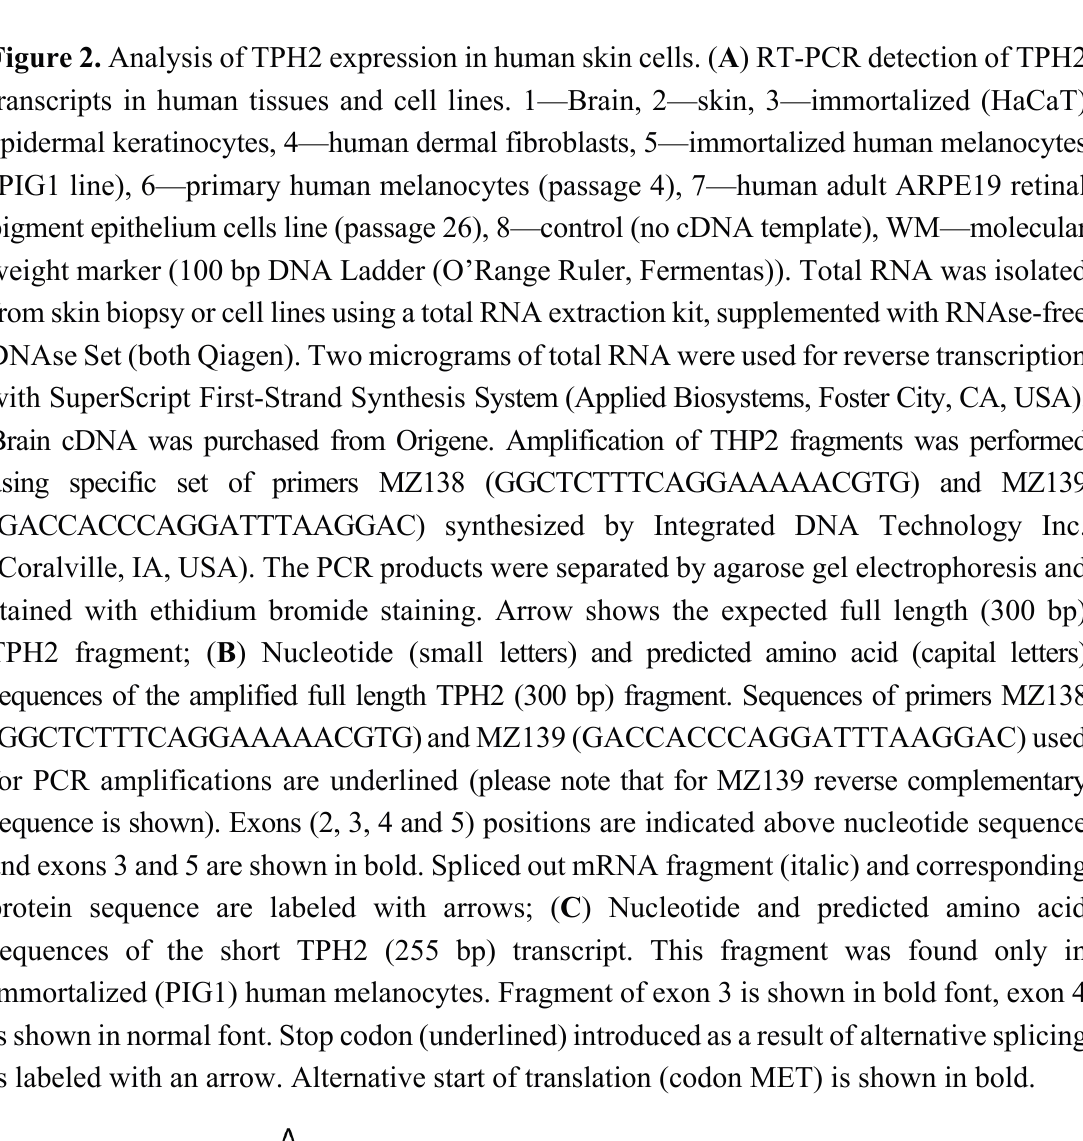
Figure 2. Analysis of TPH2 expression in human skin cells. ( A ) RT-PCR detection of TPH2 transcripts in human tissues and cell lines. 1—Brain, 2—skin, 3—immortalized (HaCaT) epidermal keratinocytes, 4—human dermal fibroblasts, 5—immortalized human melanocytes (PIG1 line), 6—primary human melanocytes (passage 4), 7—human adult ARPE19 retinal pigment epithelium cells line (passage 26), 8—control (no cDNA template), WM—molecular weight marker (100 bp DNA Ladder (O’Range Ruler, Fermentas)). Total RNA was isolated from skin biopsy or cell lines using a total RNA extraction kit, supplemented with RNAse-free DNAse Set (both Qiagen). Two micrograms of total RNA were used for reverse transcription with SuperScript First-Strand Synthesis System (Applied Biosystems, Foster City, CA, USA). Brain cDNA was purchased from Origene. Amplification of THP2 fragments was performed using specific set of primers MZ138 (GGCTCTTTCAGGAAAAACGTG) and